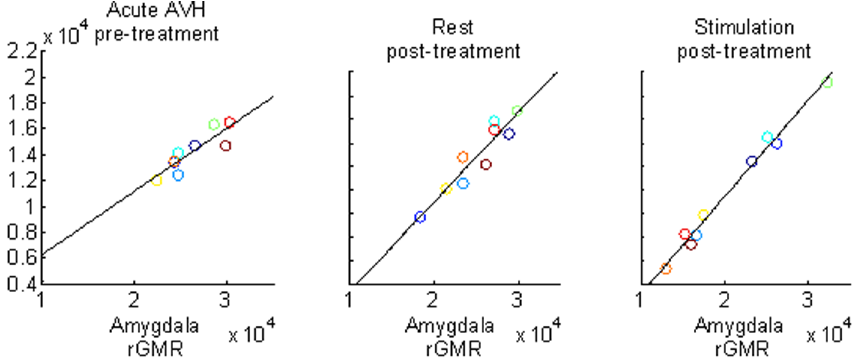
Figure 3. Functional correlations of rGMR between left amygdala and posterior (auditory) thalamus in patients. Scatterplots show positive correlations between the rGMR in the amygdala ROI and the thalamus cluster with significant group effects (Figure 2) across all three states: before treatment, in the acute phase of AVH ( left panel ), post-treatment at rest ( middle panel ), and post-treatment during auditory stimulation ( right panel ). Each patient is represented by the same color in the three panels. doi:10.1371/journal.pone.0084987.g003 PLOS ONE |